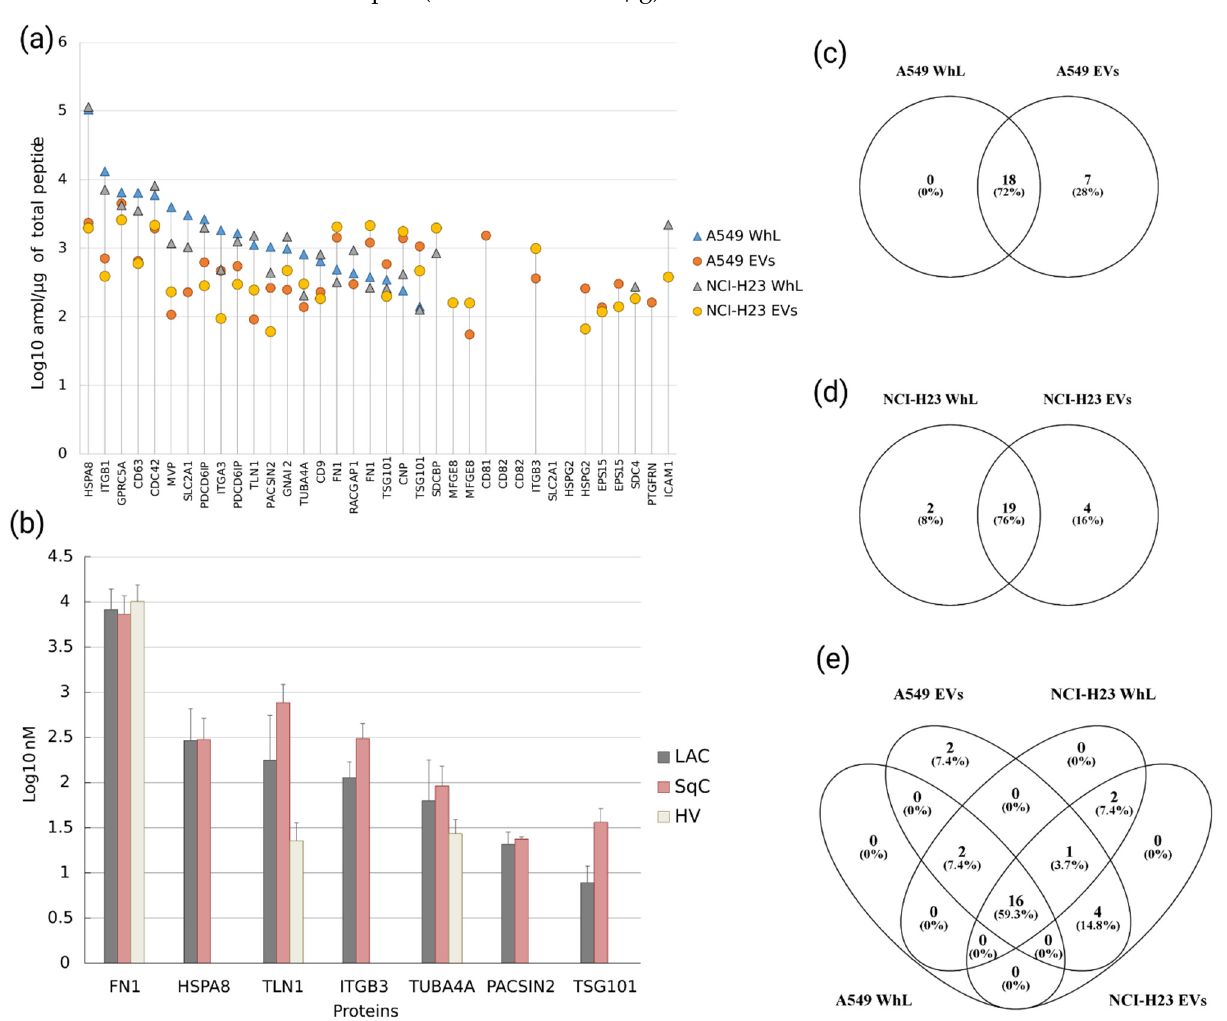
Figure 1. ( a ) Abundance of 34 peptides uniquely mapped onto 27 EV-associated proteins, which were measured in the EV and WhL samples obtained for A549 and NCI-H23 cell lines; Y-axis is log10 of the peptide content in amol/ µ g of total peptide; ( b ) abundance of 7 EV-associated proteins (FN1, HSPA8, TLN1, ITGB3, TUBA4A, PACSIN2, and TSG101) that were detected and measured in the blood plasma of 34 LC patients (23 and 11 patients with lung adenocarcinoma (LAC) and lung squamous cell carcinoma (SqC), respectively) and 23 healthy volunteers (HV); Y-axis is log10 of the protein concentration in nM; Venn diagrams demonstrate the overlap of the quantified proteins between EV and WhL of ( c ) the A549 LC cell line, ( d ) the NCI-H23 LC cell line, and ( e ) both cell lines studied.